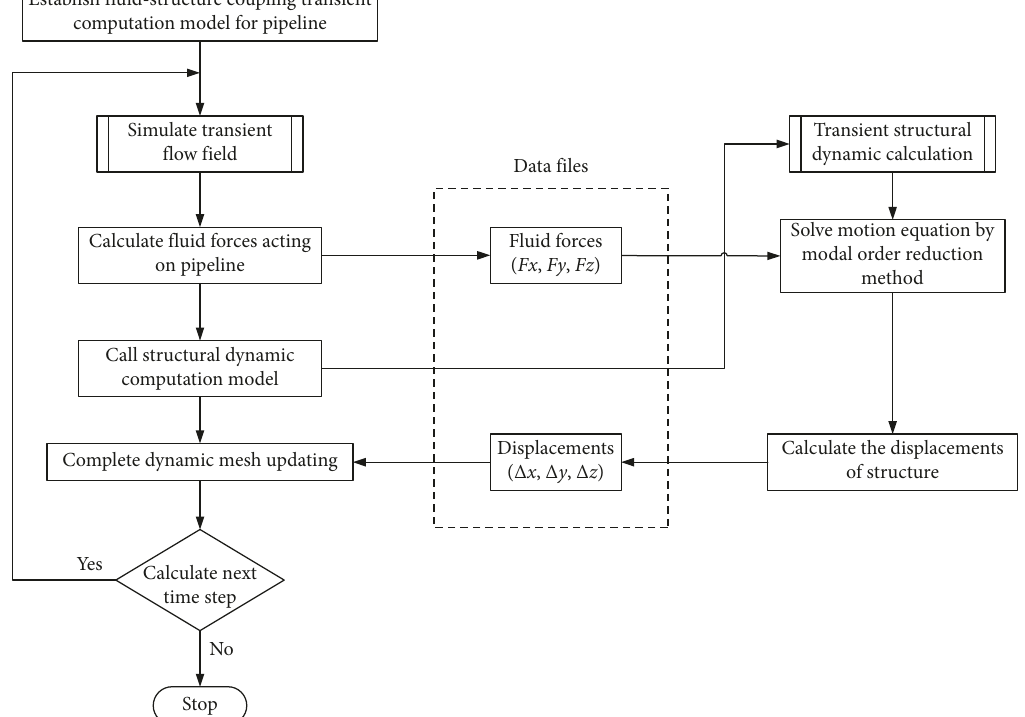
Figure 1: Flow chart of fluid-structure coupling transient calculation for pipeline